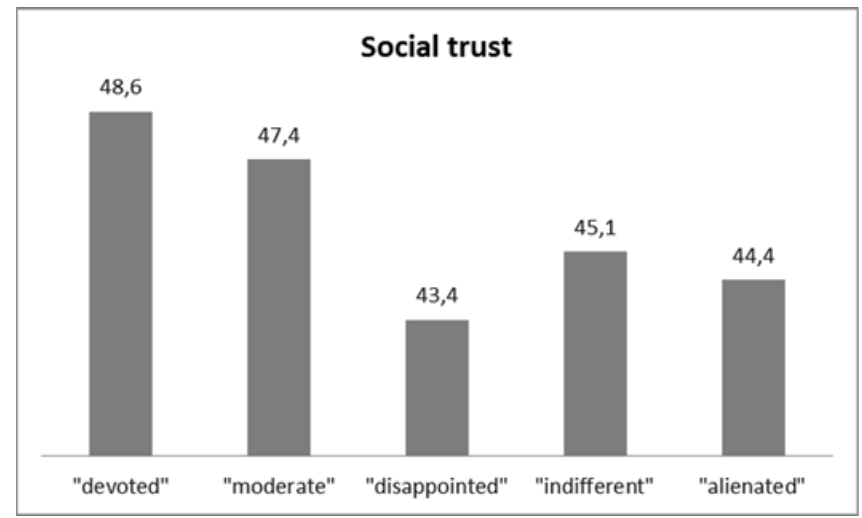
Indicators of social trust of citizens with various types of civic identity Source: Own